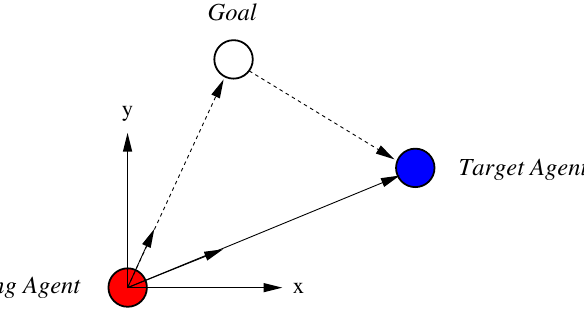
Figure 3. Relative position of agents and the goal position; the steering agent should move to the opposite side of the destination